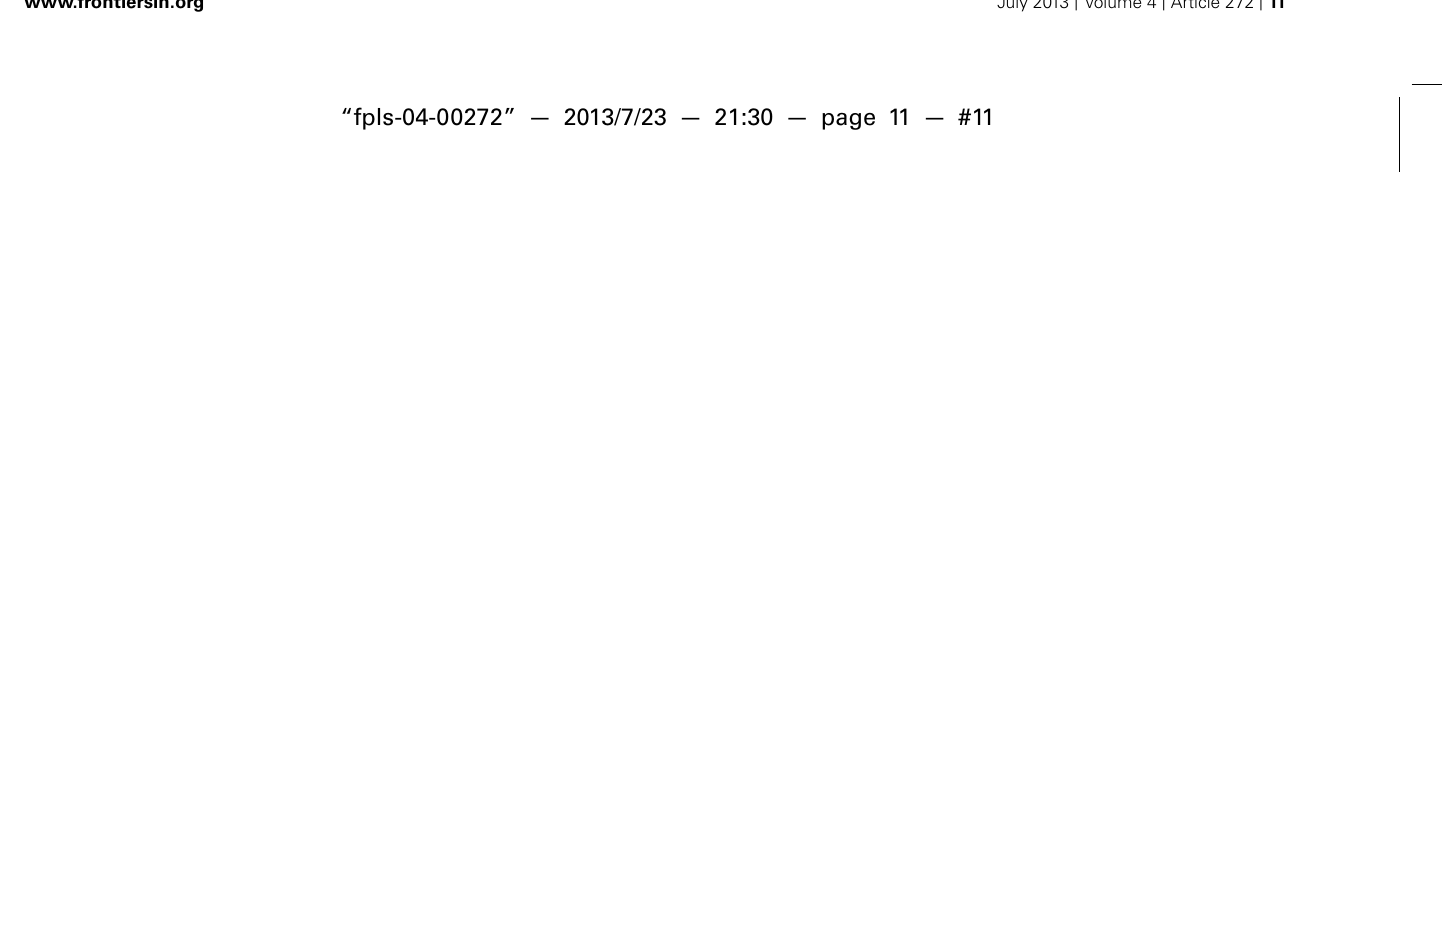
FIGURE 3 | Simplified representation of the key players involved in the competition for sugars at the plant/microbe interface. Depending on the pathosystem, plants and microbes present efficient machineries to take up or modify apoplastic sucrose. In biotrophic interactions, sucrose can be taken up by both host and fungus via sucrose transporters, e.g., maize ZmSUT1 and fungus Ustilago maydis UmSRT1, respectively. However, glucose is the main carbon source transferred from the host to the parasite and is essential for the feeding and metabolism of the parasite. Cell wall invertases from host and microbes contribute to the source of hexoses at the apoplast level. Hexose transporters allow pathogenic or mutualistic fungi to preferentially compete for glucose and/or fructose (i.e., UfHXT1, BcFRT1, CgHXTs,